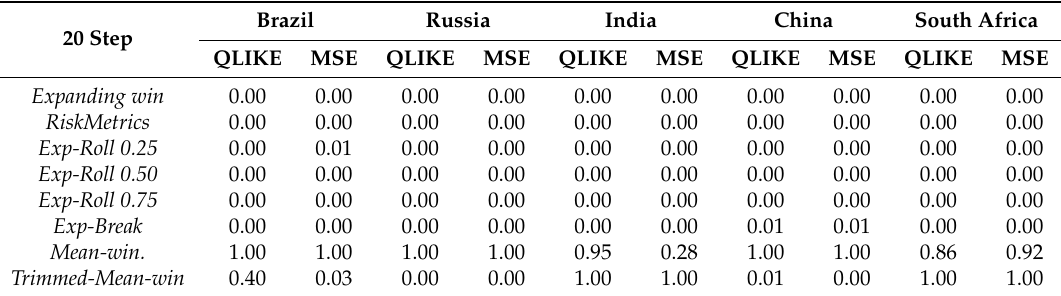
Table 6. MCS p -values for MSCI daily returns on BRICS countries. The forecasting horizon is equal to 20. The test statistic is SQ . The loss functions are MSE and